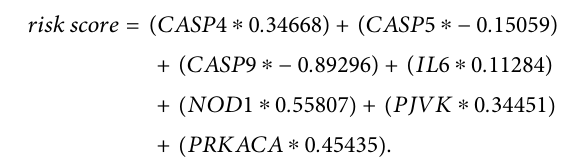
Frontiers in Genetics |